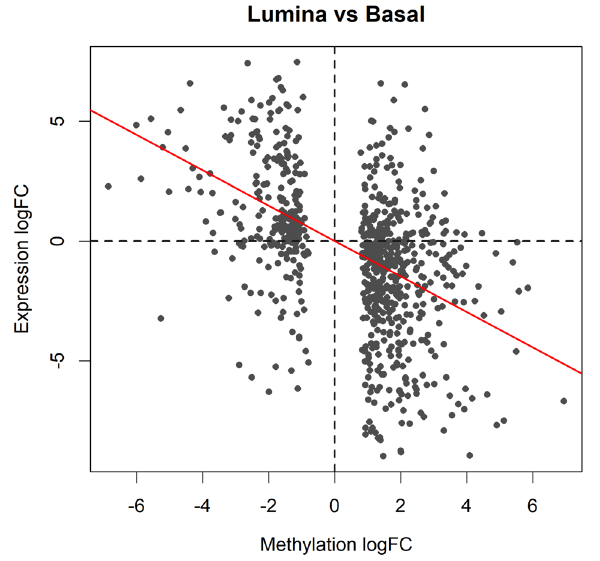
Figure 8. Scatter plot of the log-fold-changes of methylation levels in gene promoters (x-axis) vs the log fold- changes of gene expression (y-axis). The plot shows results for the genes of which the promoters are significantly differentially methylated between basal and luminal. The red line shows the least squares line with zero intercept. A strong negative correlation is